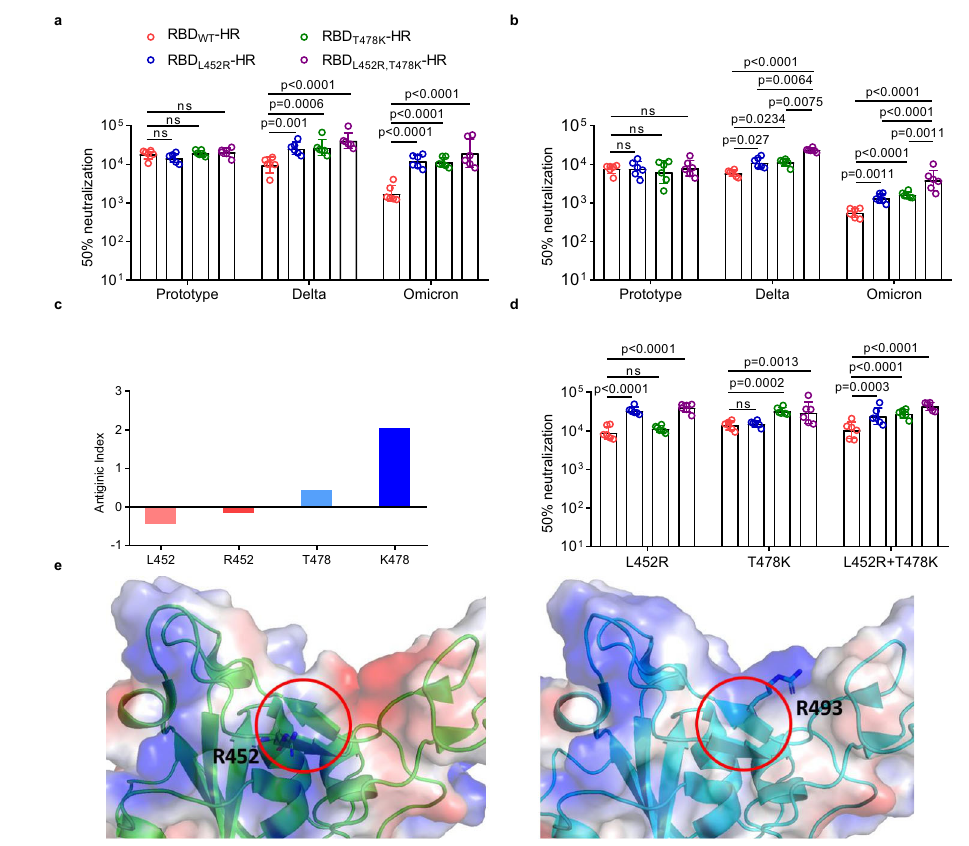
Fig. 3 | Mutations of L452R and T478K both bene fi t to antibody response against Omicron and Delta variants. a NIH mice were immunized with 10 μ g of adjuvant-formulated RBD WT -HR, RBD L452R -HR, RBD T478K -HR, and our RBD-HR/tri- mer, serum samples were collected on day 56 to assay the neutralizing antibodies against prototype, Delta and Omicron pseudovirus ( n =6 mice per group). b Neutralizing antibody titers in vaccinated mice after two doses of immunization ( n =6micepergroup). c AntigenicityanalysesoftheSARS-CoV-2original-strainand Delta-variantRBDs using theJameson-Wolfmethod. The antigenicindex values for the L452/R452 and T478/K478 pairs are recorded and further presented using histograms. d Neutralizing antibody titers induced by RBD WT -HR, RBD L452R -HR, RBD T478K -HR, and RBD-HR/trimer against mutated psudoviruses containing signal